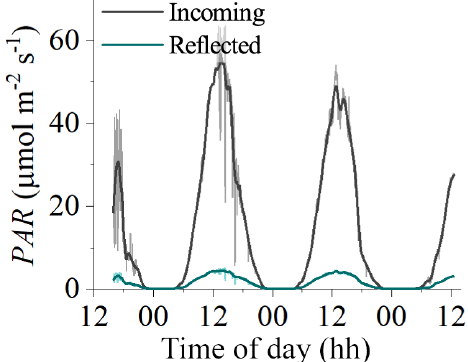
Figure 8. Measurements of incident and reflected seabed PAR made using two cosine PAR sensors over a habitat with bare sediments at 8m depth in Oslofjord in July 2019. Reflected PAR was typically 8%–10% of incident PAR, indicating that ∼ 90% of incident PAR was absorbed by the